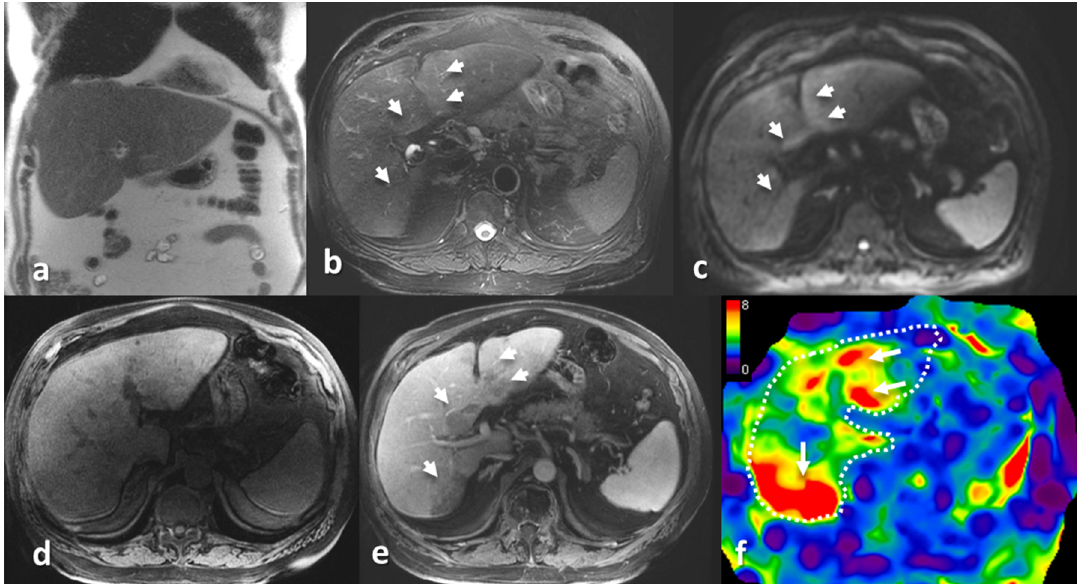
Figure 4. A 64-year-old male with known pulmonary amyloidosis on follow up. A follow-up CT (not shown) revealed hypodense lesions in the liver. An MRI with MRE was performed. The coronal T2-weighted image ( a ) shows borderline hepatomegaly (15.5 cm). The spleen was also borderline enlarged (12 cm). Multifocal lesions (arrow heads) were found in both lobes of the liver, which appeared hyperintense on the axial T2-weighted image ( b ) and diffusion weighted image ( c ), hypointense on the T1-weighted image ( d ), and hypoenhancing on the post contrast image ( e ). The MRE stiffness map ( f ) with a scale of 0–8 kPa shows moderately elevated liver stiffness (mean ± SD, 4.6 ± 0.8 kPa) with focal increased stiffness regions corresponding to the focal lesions. A percutaneous biopsy performed on the right lobe lesions confirmed hepatic amyloidosis.